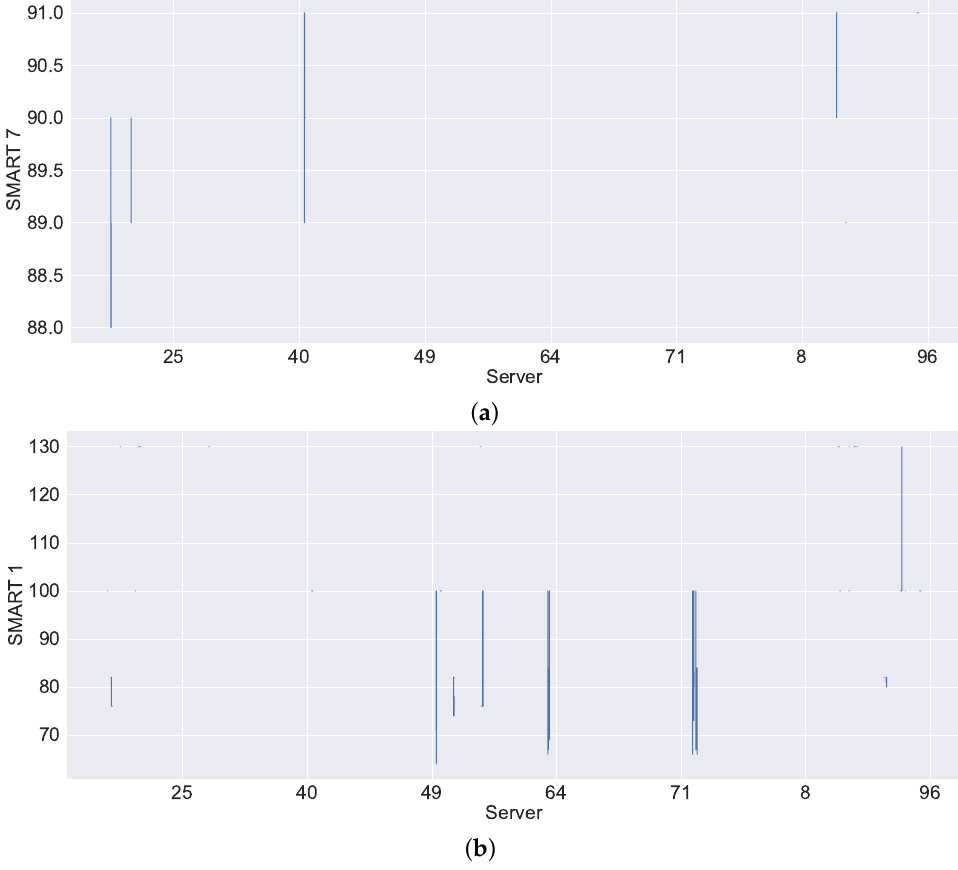
Figure 10. Visualisation of SMART 7 and SMART 1 based on the server. ( a ) Visualisation of SMART 7; ( b ) visualisation of SMART